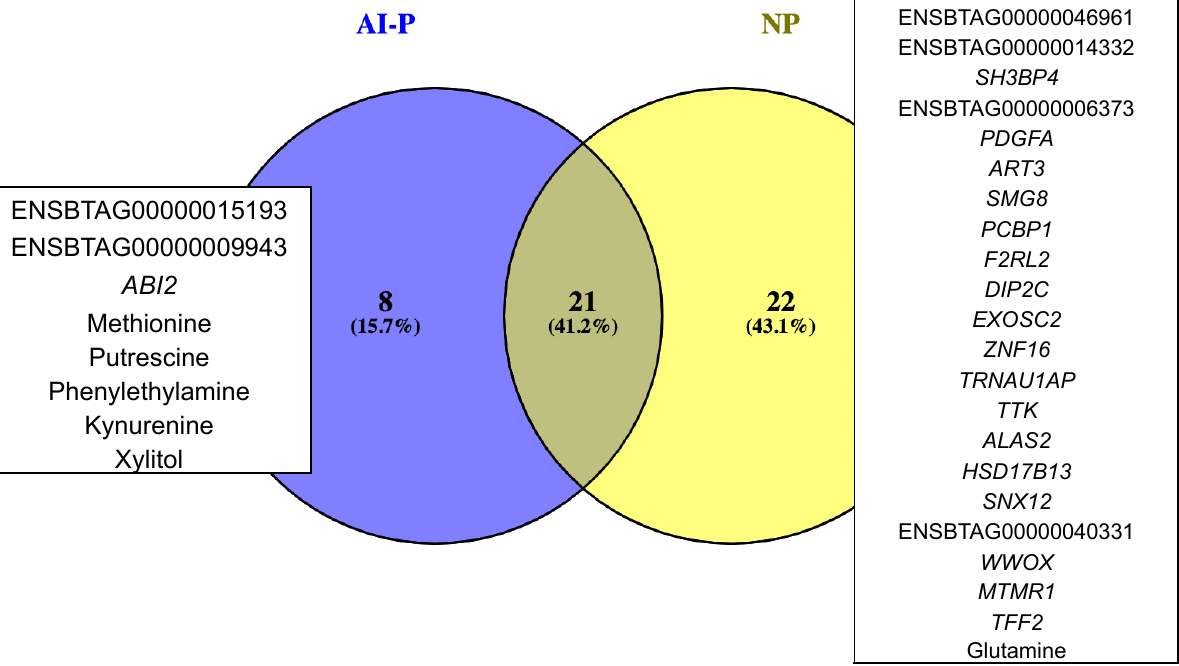
Figure 5. Gene and metabolite targets exclusive for the AI-P and NP